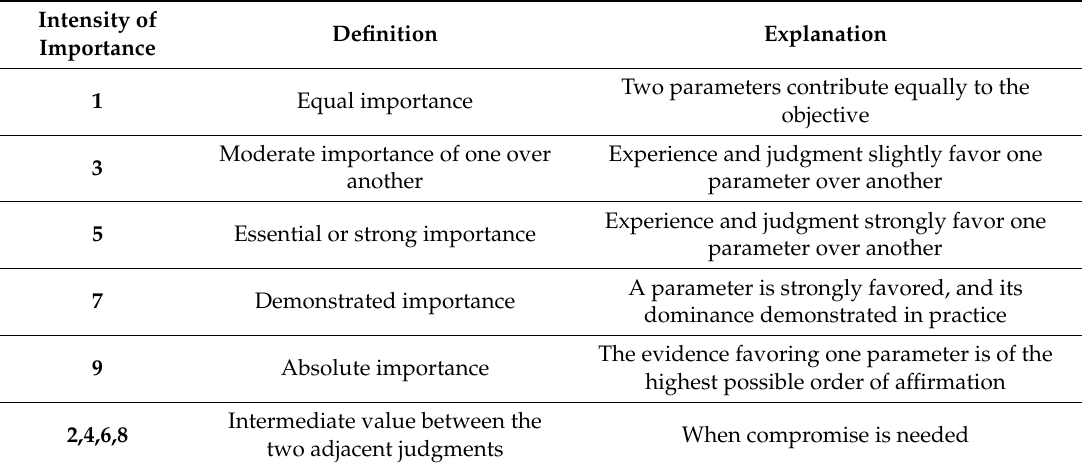
Table 3. The scale for pairwise comparison.